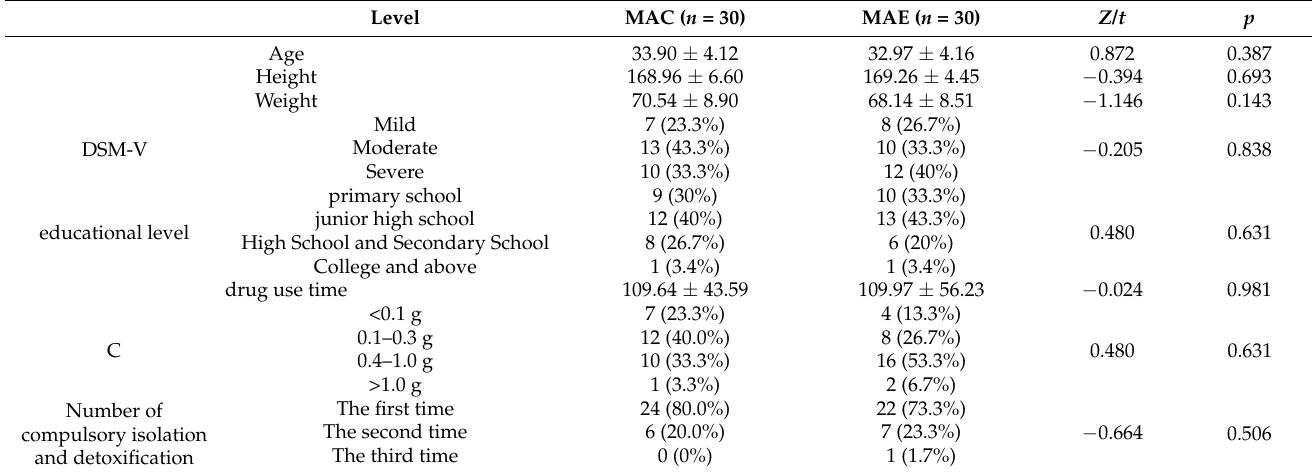
Table 1. Baseline conditions of subjects in both groups.